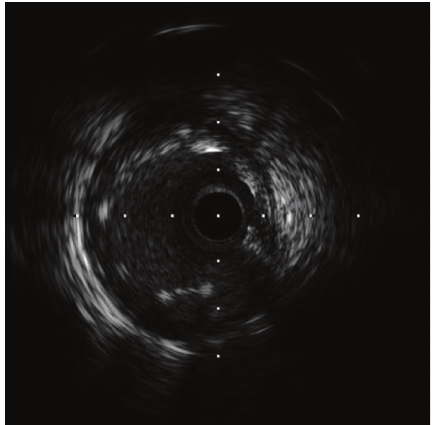
Figure 2: Intravascular ultrasound imaging revealed incomplete apposition of the stent struts in the proximal edge.